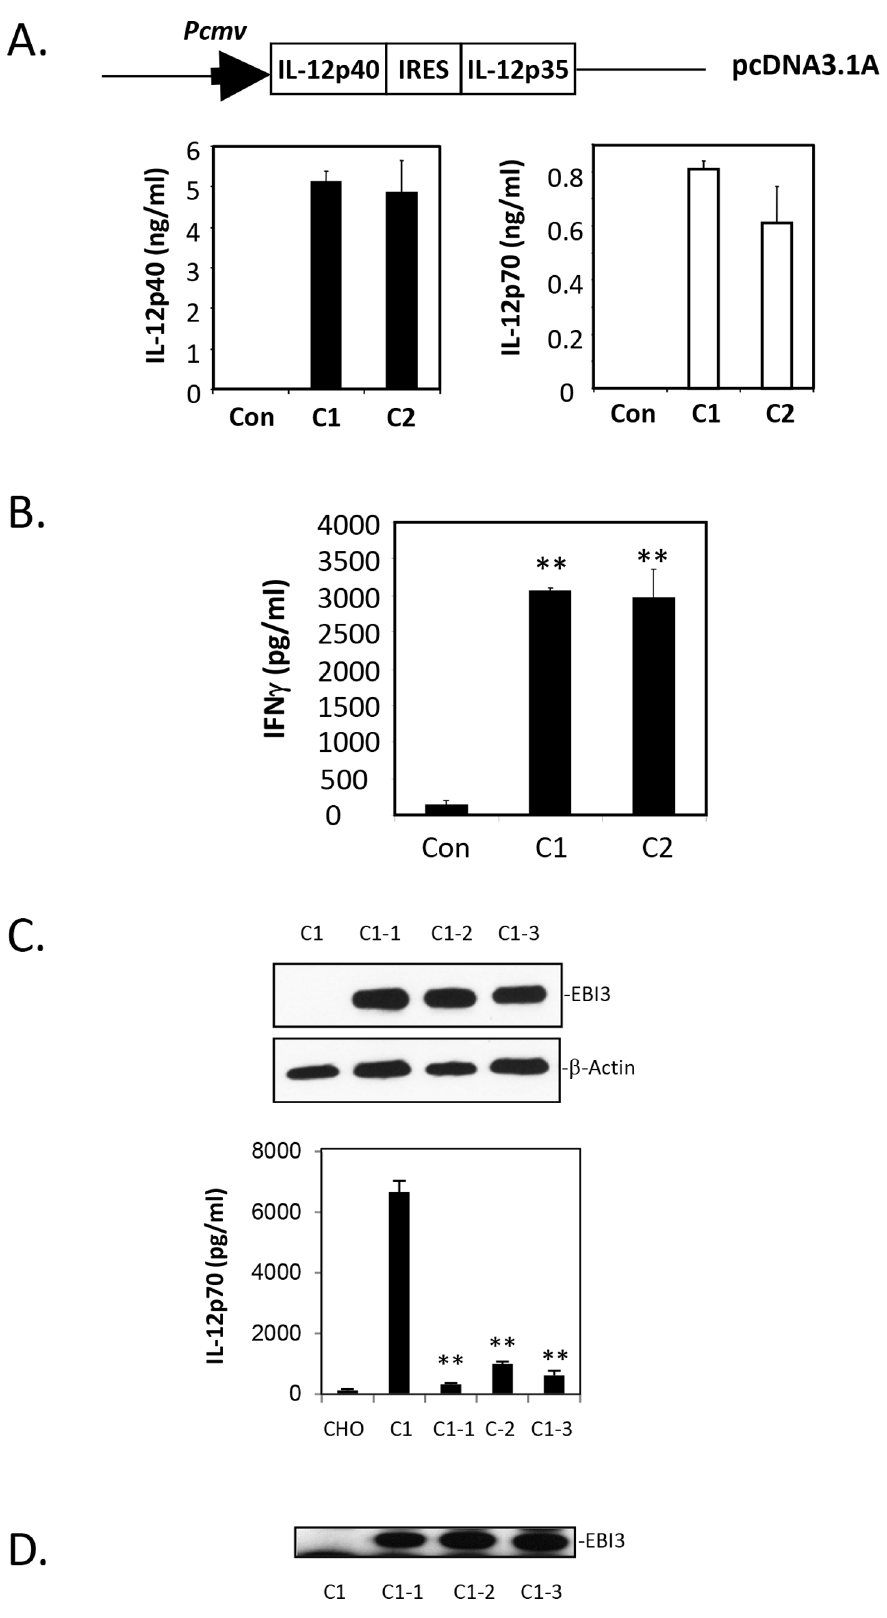
Figure 4. Over-expression of EBI3 blocks IL-12p70 production in CHO cells. A. Biscistronic IL-12p40 and p35 expression were compared before being introduced into a CHO cell by transfection. Two clones (C1 and C2) with comparable levels of IL-12p40 and IL-12p70 as detected by ELISA were selected. B. The biological activity of IL-12 was detected by inducing IFN c production in C57/black mouse CD4 + T cells. C. The EBI3